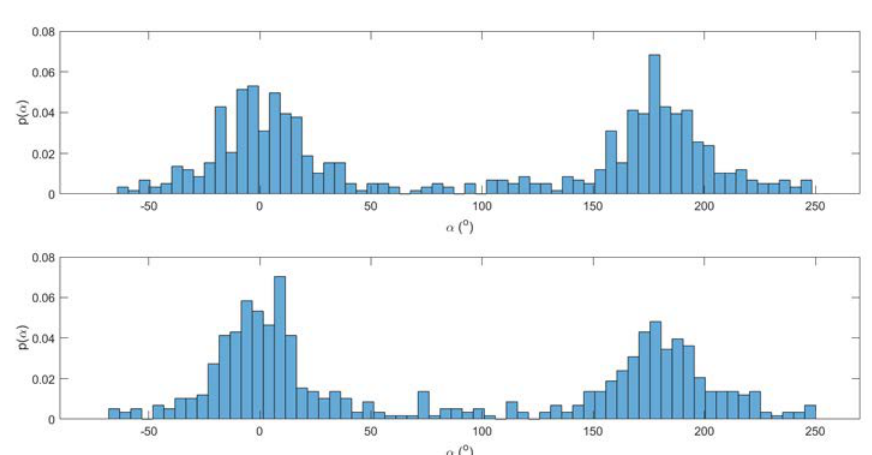
Figure 6. Elevation angle histograms for the 2D network for instrument location set 1 (top) and set 2